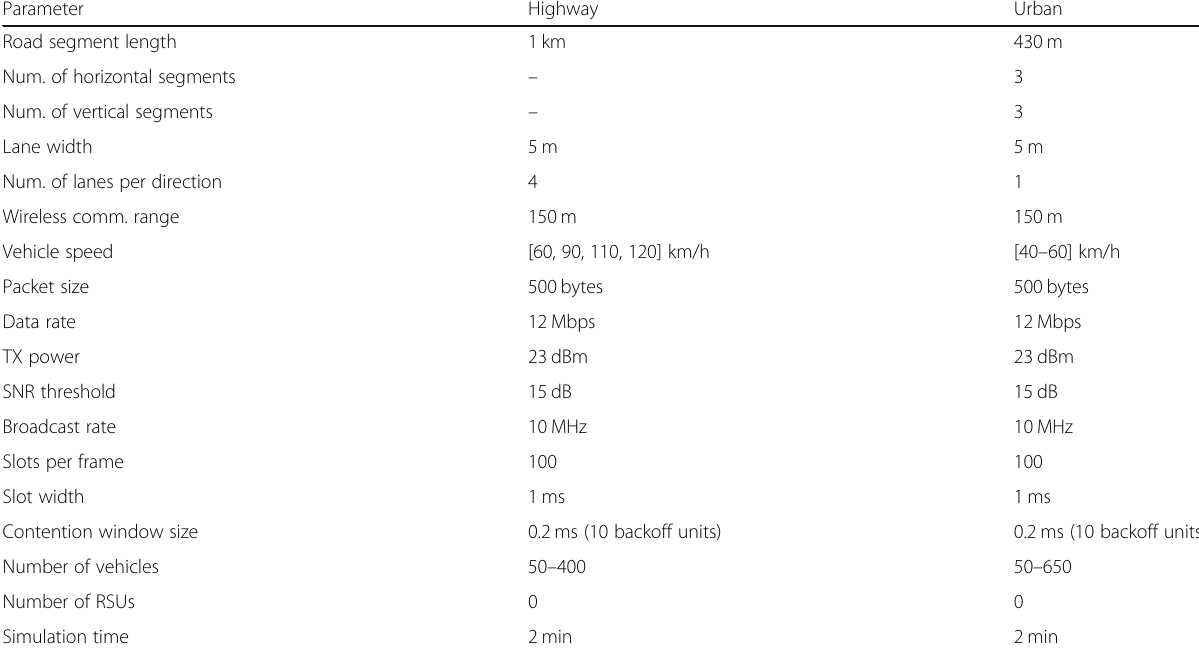
Table 1 Simulation